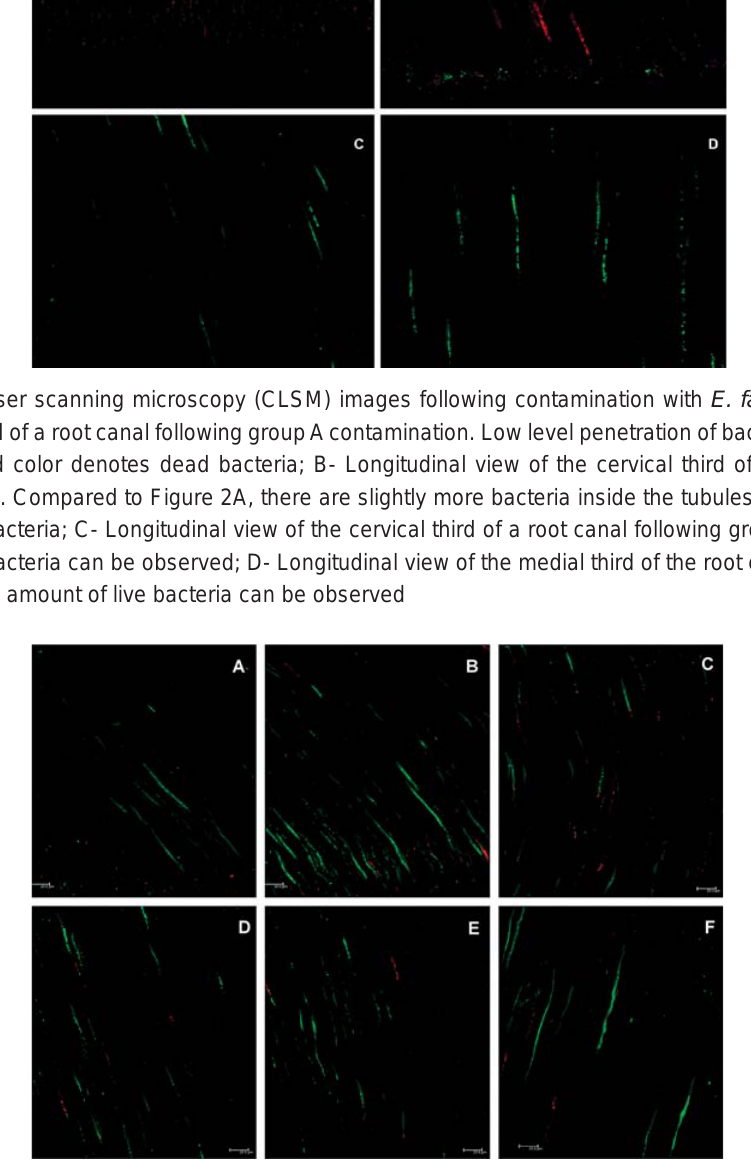
Figure 3- Confocal laser scanning microscopy (CLSM) images following group C contamination protocol. A, B, and C- Longitudinal views of the cervical third of a root canal. A greater quantity of bacteria and a predominance of live (green) bacteria can be observed; D, E, and F- Longitudinal views of the medial third of a root canal. Live bacteria can be observed.